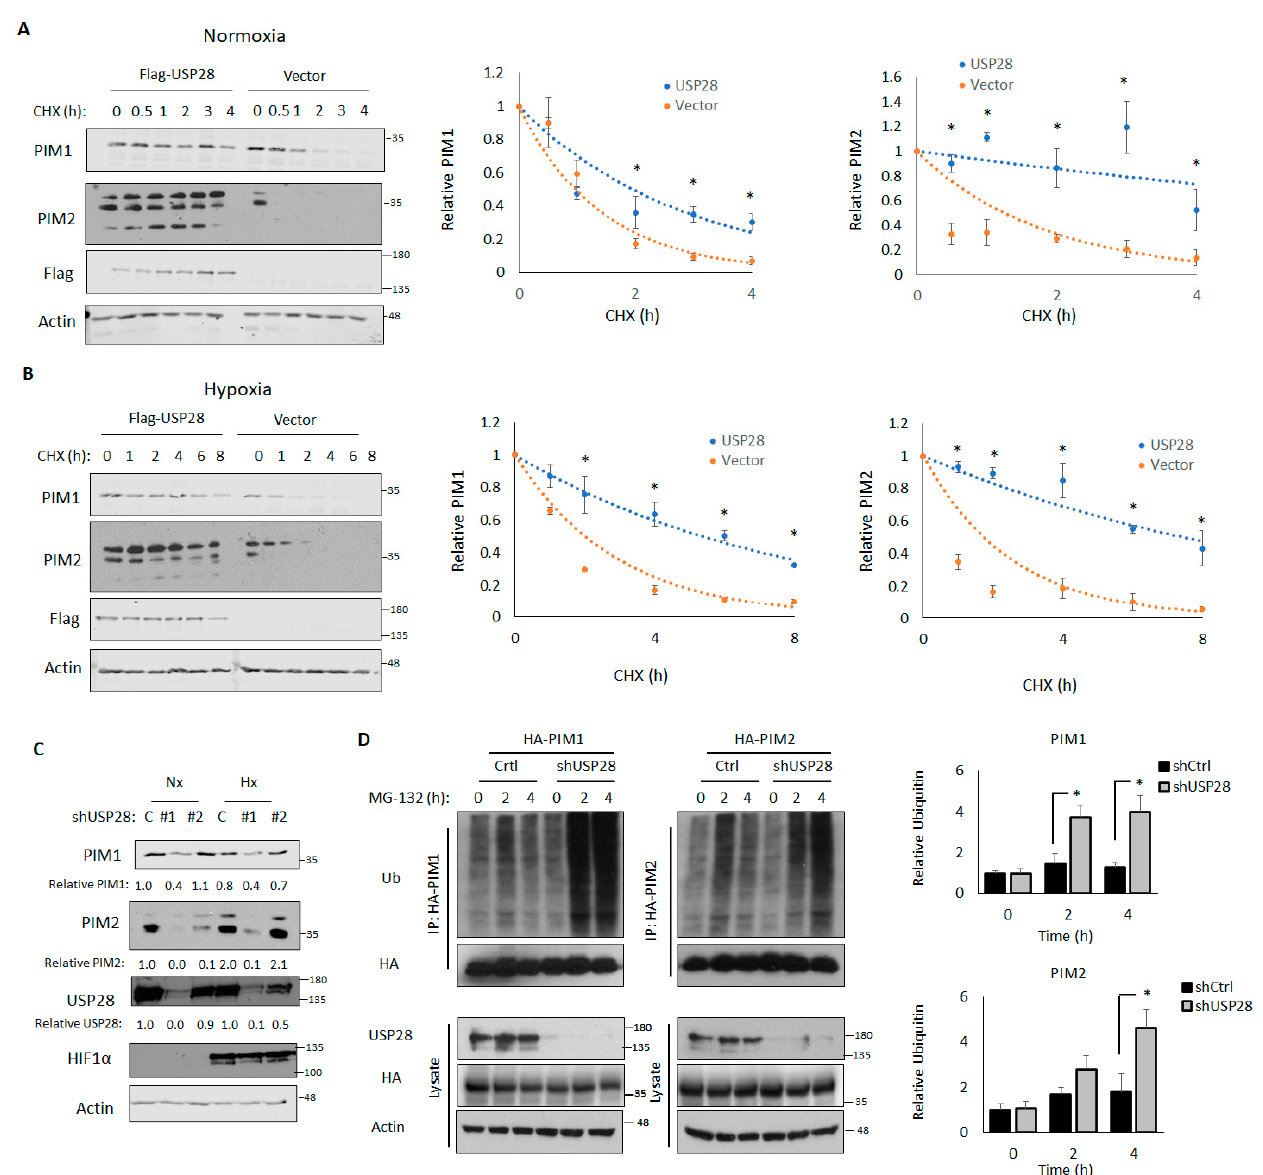
Figure 3. USP28 controls PIM1/2 stability in normoxia and hypoxia. 293T cells were co-transfected with HA-PIM1 and Flag-USP28 or a control vector. Cells were then treated with 10 µM cycloheximide (CHX) for 30 min, 1, 2, 3, or 4 h in normoxia ( A ) or 1, 2, 4, 6, or 8 h in hypoxia ( B ), and lysates were harvested for western blotting. Middle, quantification of PIM1; right, quantification of PIM2. Quantifications represent the results of three independent experiments. Error bars indicate the standard error of the mean. ( C ) PC3-LN4 USP28-knockdown cells were created by transducing PC3-LN4 cells with USP28 short hairpin RNAs. Control cells were transduced with a control vector. Control and USP28-knockdown cells were transfected with HA-PIM1 and cultured for 6 h in hypoxia. Lysates were harvested for western blotting. ( D ) PC3-LN4 control and USP28-knockdown cells were transfected with HA-PIM1 or HA-PIM2 and treated with MG-132 for 2 or 4 h to block protein degradation. HA-PIM1/2 were immunoprecipitated, and immunoprecipitated and input lysates were used for western blotting. Right, quantification of relative ubiquitin density. * p < 0.05.